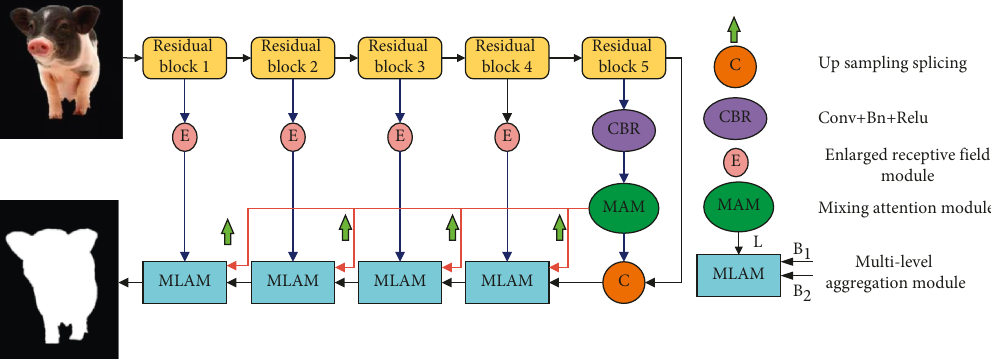
Figure 2: Network structure diagram.